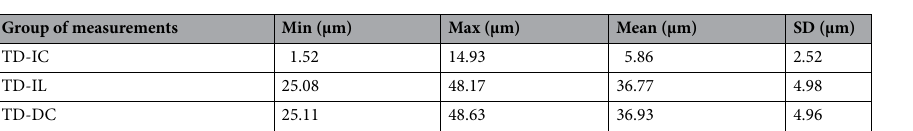
Table 1. Minimal (Min), maximal (Max), mean values, and standard deviation (SD) calculated for tangential dimension of an intrusively growing initial cell (TD-IC), tangential dimension of two radial files adjacent to intrusively growing initial together with tangential dimension of intrusively growing tip of initial—measured in initial layer (TD-IL), and tangential dimension of the same two radial files as in TD-IL, but distanced (5–6 cells) from an initial layer